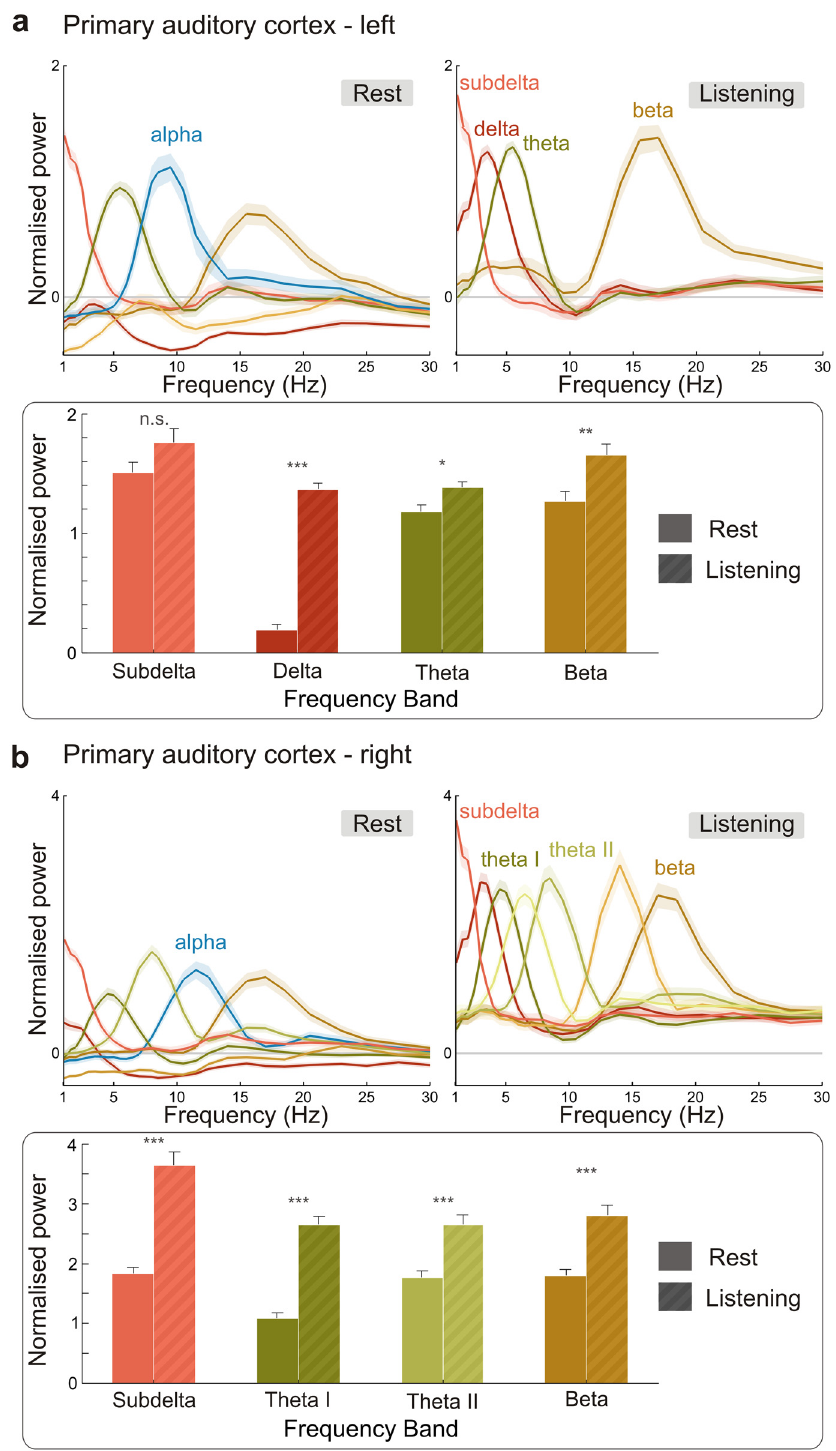
Fig 6. Comparison of spectral profiles in (a) left and (b) right primary auditory cortices during rest and listening. Upper panels for left and right PAC show spectral profiles including all modes for the rest (left) and listening (right) conditions. The x -axis is limited to 30 Hz. The amplitudes of spectra with comparable peak frequencies in both conditions were subjected to an independent sample t test across participants (lower panels). Bars illustrate amplitude means across individual spectra that contributed to group clusters. Error bars illustrate standard error of the mean across participants. Asterisks